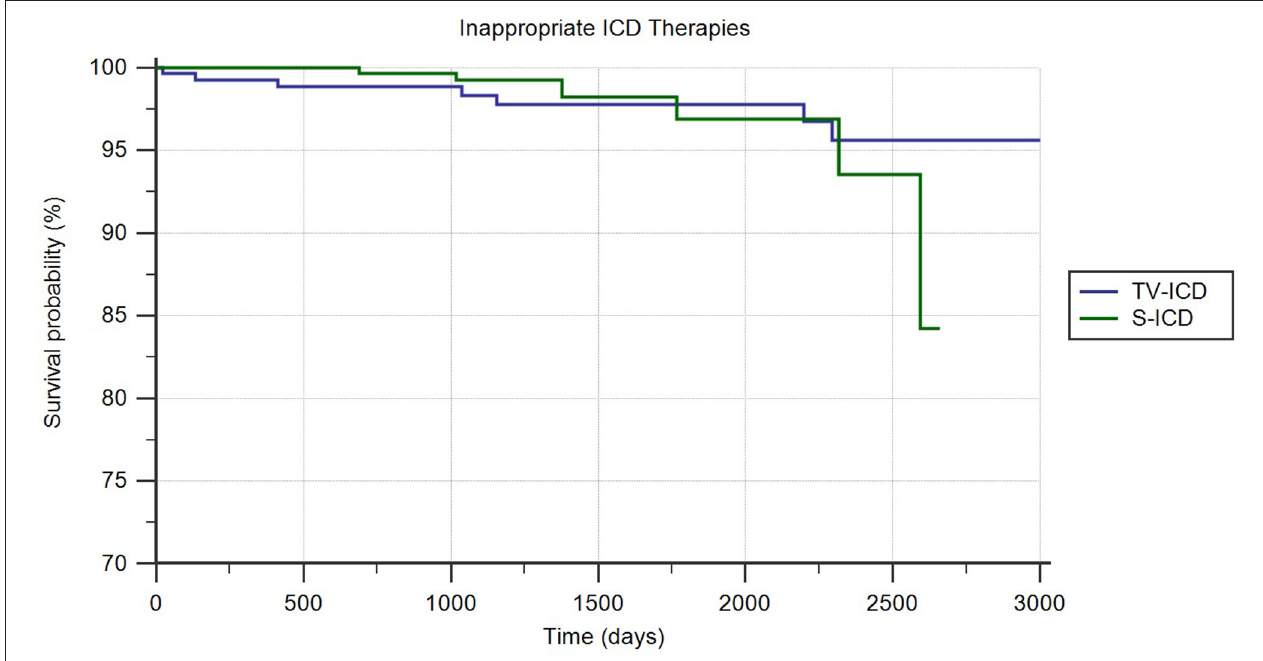
FIGURE 1 | Kaplan-Meier curve comparing survival without ICD-related infections among S-ICD vs. TV-ICD groups.